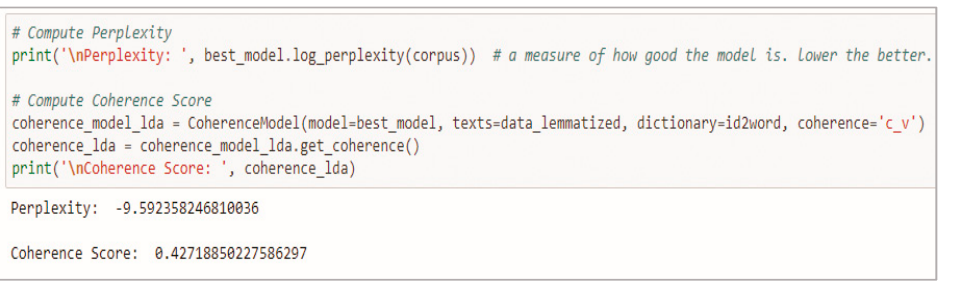
, Figure 8. Code 5: TF-IDF Vectorization, own elaboration.